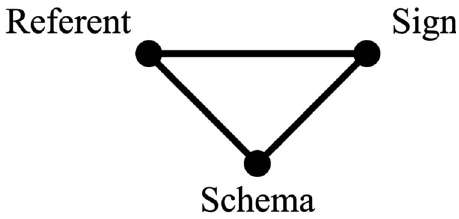
FIG. 1. Relationship between sign, referent, and schema.